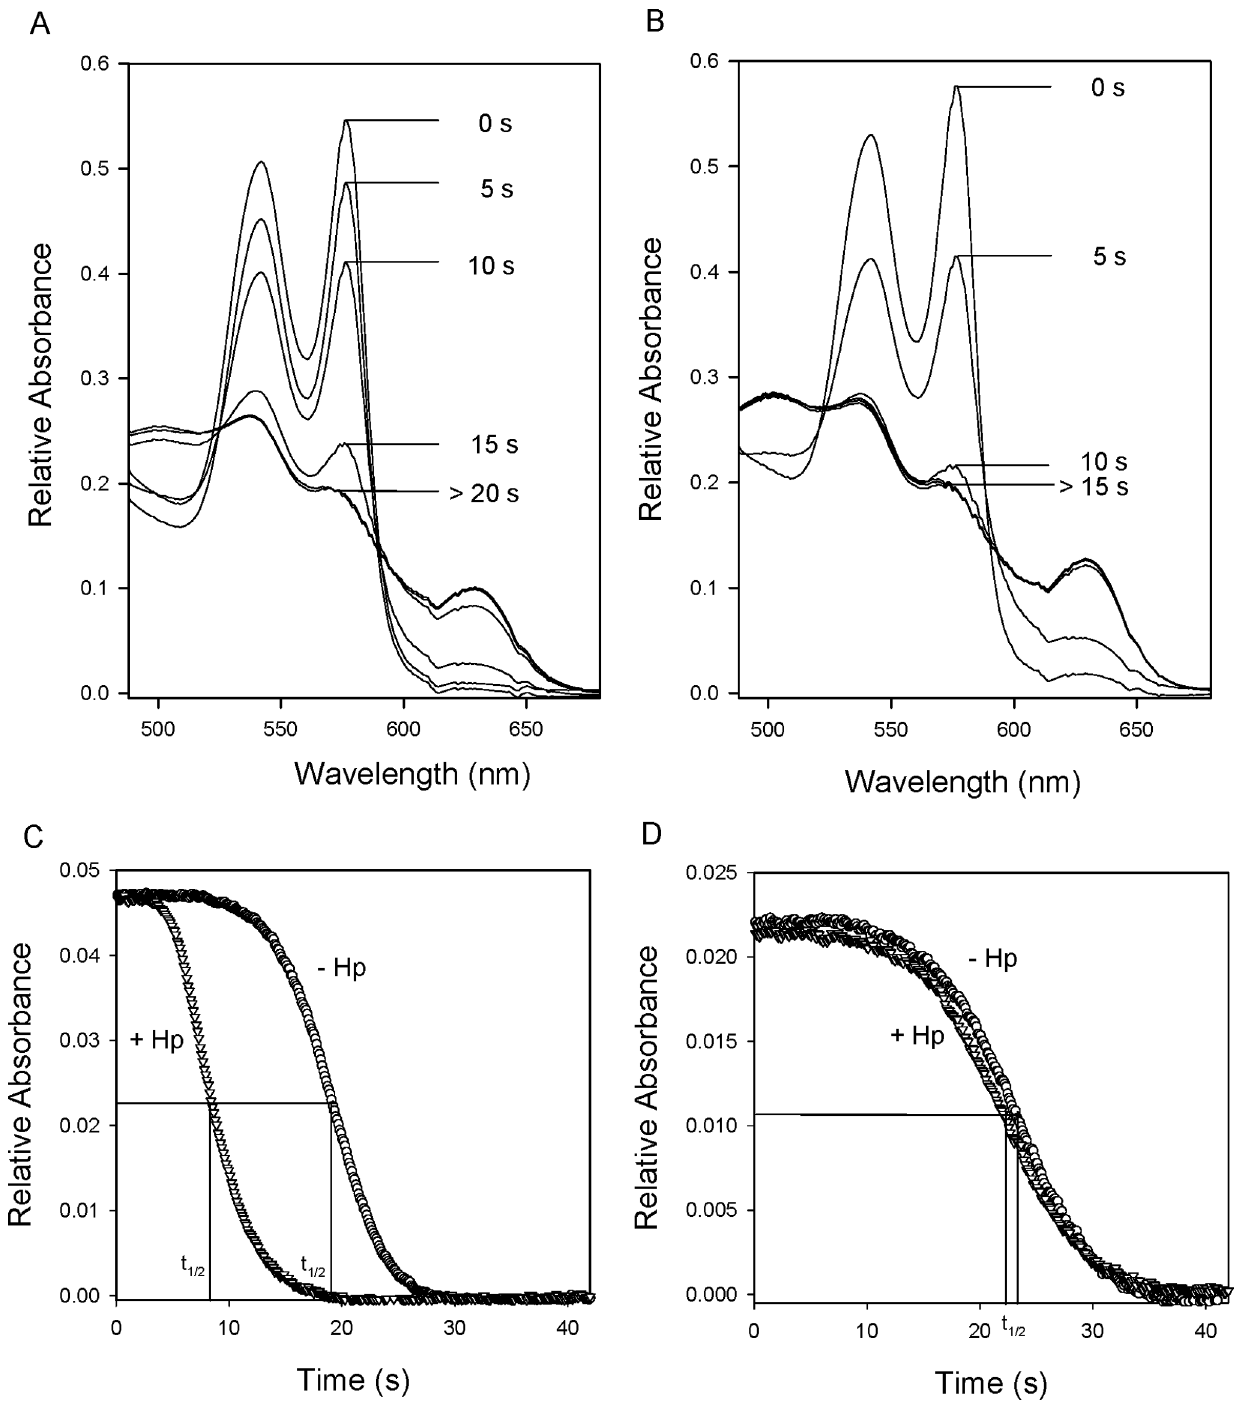
Figure 7. Nitrite reaction with oxy HbA and bb XLHb in the presence and absence of Hp. The spectral changes over time were measured in a spectrophotometer for the reaction of oxy HbA (30 m M) and nitrite (6 mM) in the absence (A) or the presence (B) of excess Hp. The kinetics of oxy HbA (C) and bb XLHb (D) reacting with freshly prepared nitrite as measured by rapid mixing, and the absorbance change was monitored at 577 nm. The time courses of the complex nitrite-induced Hb oxidation processes in the absence (open circle) and presence (open triangle) of Hp were illustrated, and the half times of the reaction under the same conditions were derived and listed in Table 2. doi:10.1371/journal.pone.0059841.g007 and a cutoff filter , 360 nm for emission as a function of time. At rate constant for each reaction. Bimolecular rate constants were least three time courses of Hp binding with Hbs were fitted to derived from the slope of the linear relationship of the apparent exponential equations to obtain the averaged pseudo-first-order association rate constants as a function of Hb concentration.